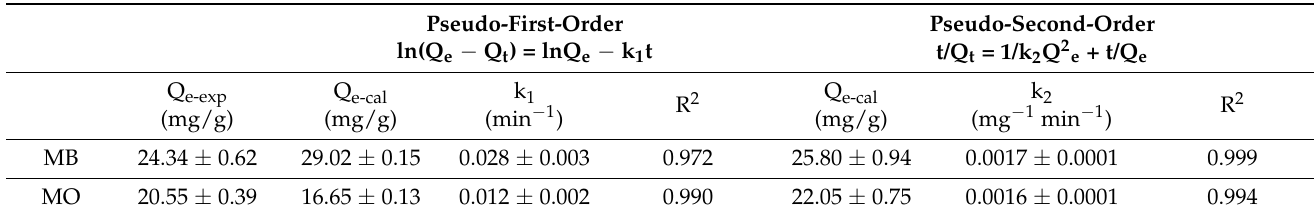
Table 2. The kinetic parameters for the adsorption of MB and MO onto the mPVA/AC CG. Pseudo-First-Order